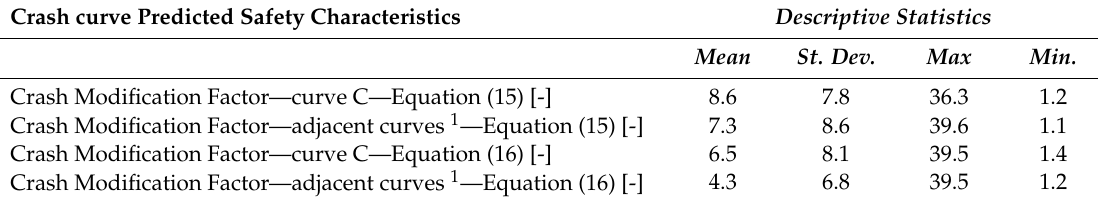
Table 4. Descriptive statistics of the predicted safety features of ROR FI curved crash sites (each statistic was computed over the total number of curve sites